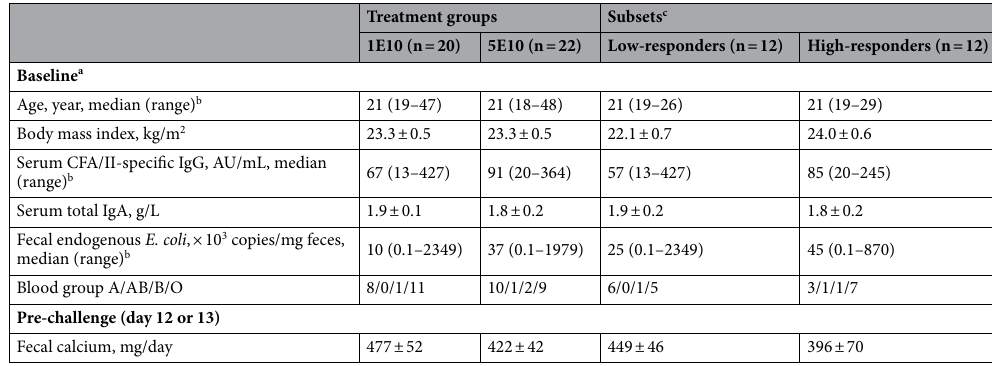
Table 1. Baseline and pre-challenge characteristics of study participants. a Data are expressed as mean ± SEM, unless stated otherwise. b Subjects were stratified to the inoculation dose groups according to age, CFA/ II-specific serum IgG titer at baseline, and fecal endogenous E. coli count. c High- and low-responder subsets were defined by ranking all subjects based on a combination of all clinical outcomes after the first E. coli challenge (see “Methods” section). The sub-groups contained equal numbers of subjects from each dose group (n = 6 of each